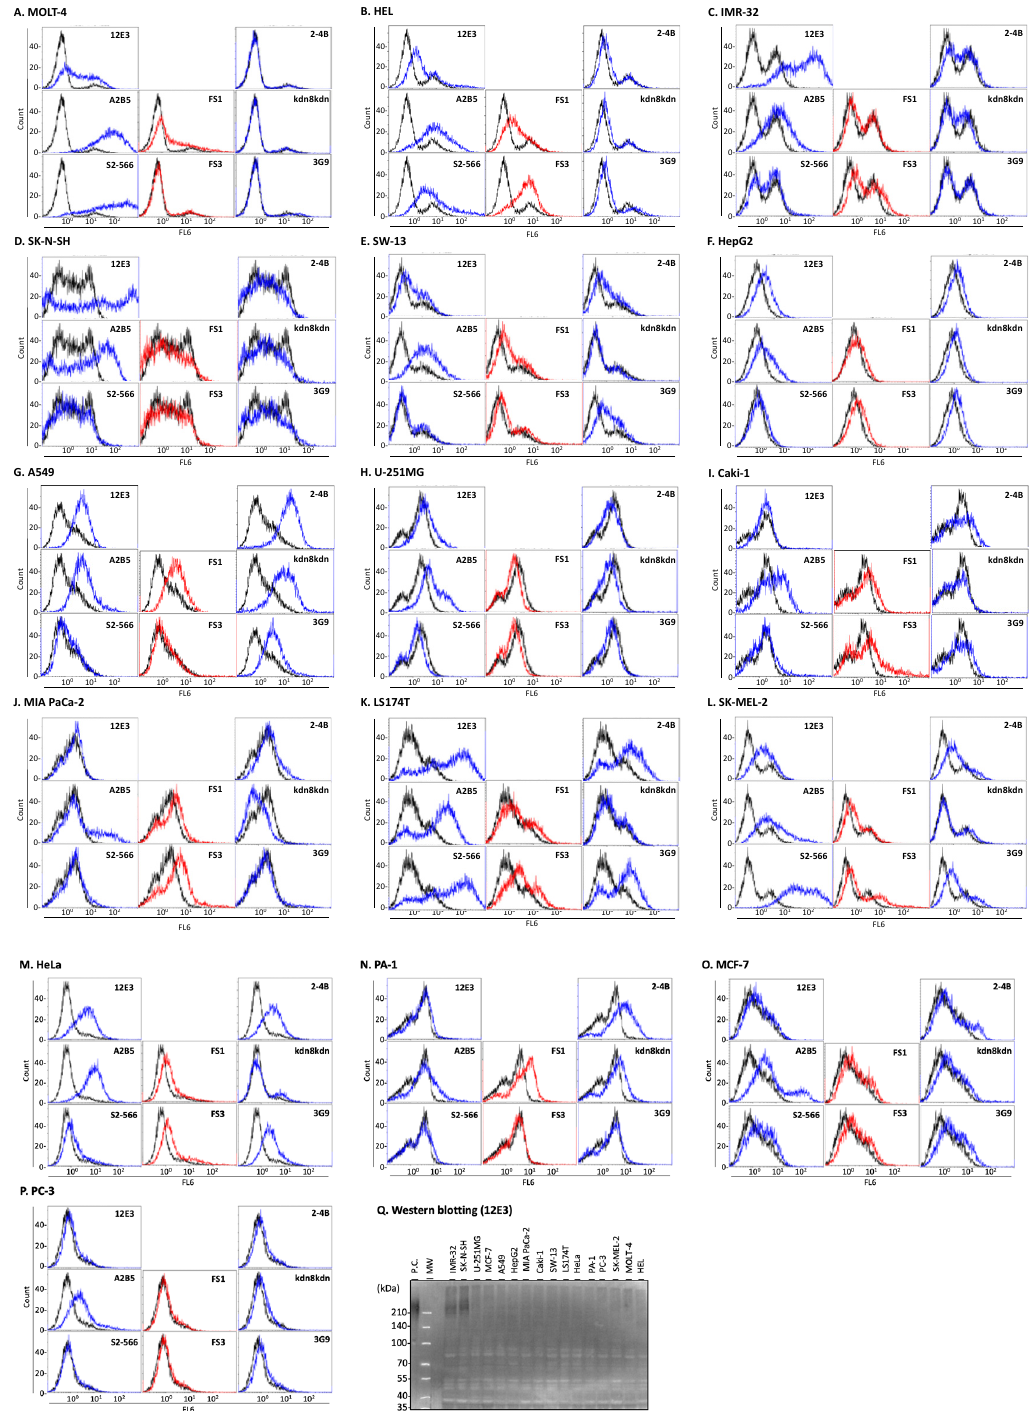
Figure 2. Flow cytometric analysis of cancer cell lines. Human cancer cell lines were analyzed by flow cytometry using eight different anti-sialoglycoconjugate antibodies. Cell surface expression profiles of sialoglycoconjugates are shown in ( A ) MOLT-4, ( B ) HEL, ( C ) IMR-32, ( D ) SK-N-SH, ( E ) U-251MG, ( F ) HepG2, ( G ) A549, ( H ) SW-13, ( I ) Caki-1, ( J ) MIA PaCa-2, ( K ) LS174T, ( L ) SK-MEL-2, ( M ) HeLa, ( N ) PA-1, ( O ) MCF-7, and ( P ) PC-3. Black lines, negative control (control antibody); blue lines, anti- sialoglycoconjugate antibodies (mouse IgM); red lines, anti-sialoglycoconjugate antibodies (mouse IgG). ( Q ) Western blot analysis of the cancer cell lines by 12E3 antibody for polySia–NCAM. P.C., positive control (pig embryonic brain homogenate); MW, molecular size